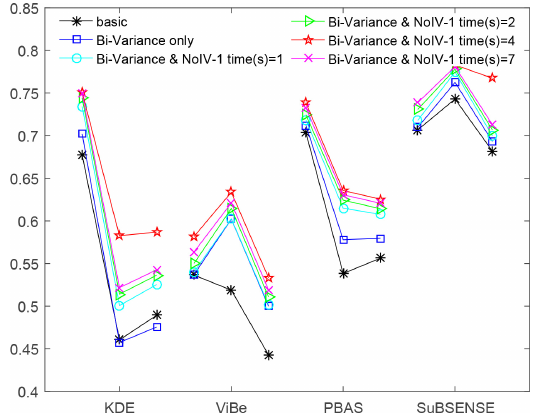
Figure 8. Results in Tables 1–4 are drawn here. In each broken line, the three vertices stand for recall , precision , and F-measure , from left to right.